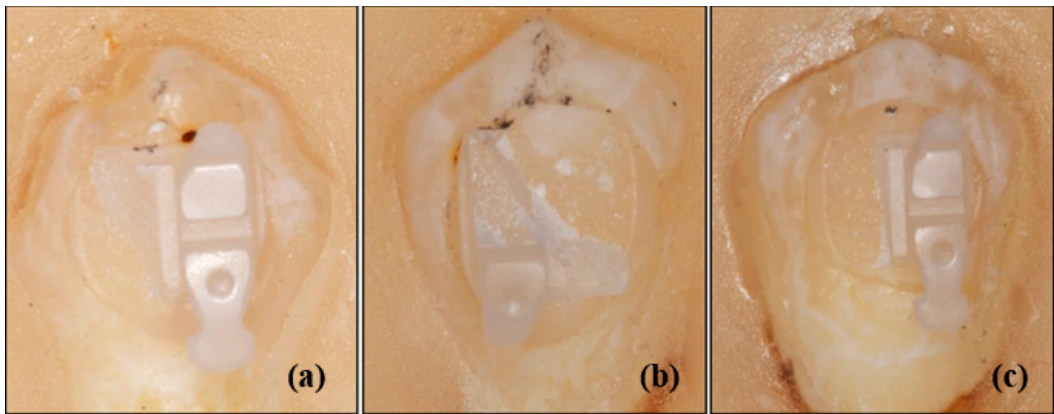
Figure 5. Gemini Clear ceramic bracket samples with wing break. ( a , c ) Two of the four bracket wings were broken, and two intact bracket wings remained, ( b ) Three of the four bracket wings were broken, and one intact bracket wing remained.